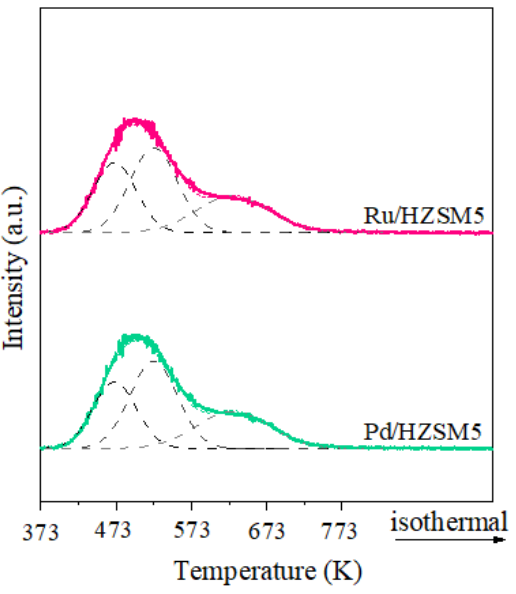
Figure 5. NH 3 -TPD profiles of Pd/HZSM5 and Ru/HZSM5 after reduction (30 bar H 2 and 673 K) .